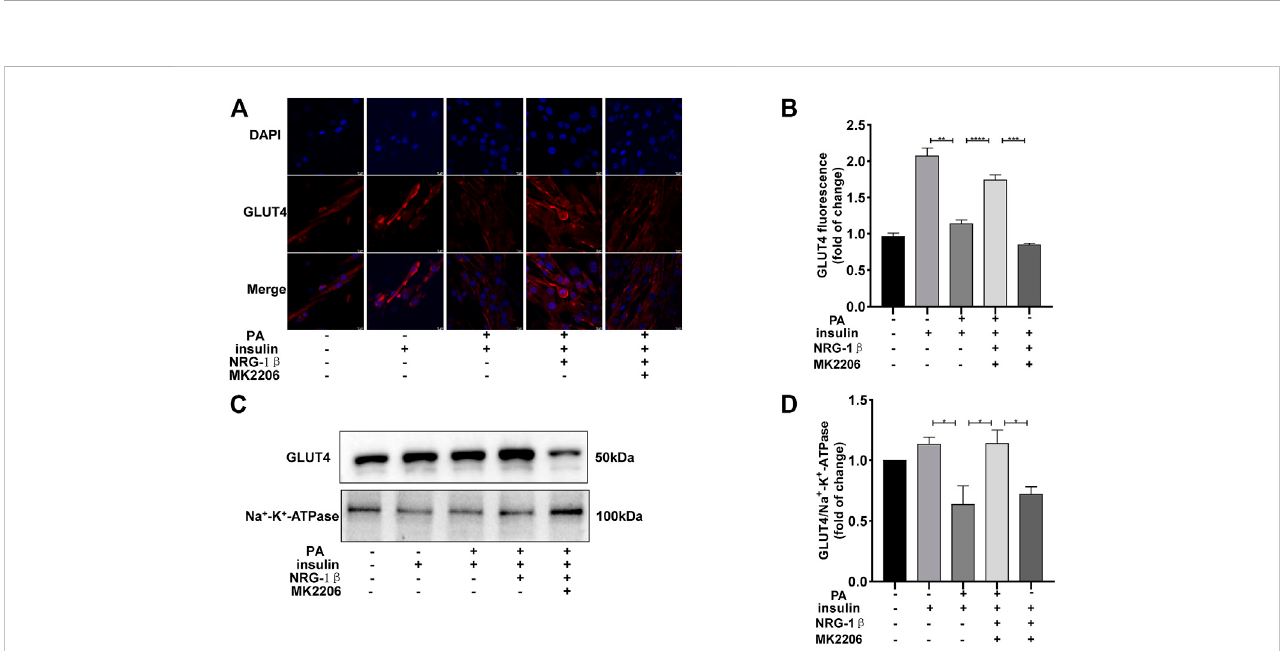
FIGURE 4 NRG-1 β promoted the translocation of GLUT4 in PA-treated C2C12 myotubes by activating the PI3K/AKT signaling pathway. Effects of MK2206 of GLUT4 translocation in PA-treated C2C12 myotubes, GLUT4 was detected by using a fl uorescent anti-GLUT4 antibody (Scale bar: 10 μ m) (A,B) and Western blotting (C,D) . The data are presented as the mean ± SEM. * p < .05; ** p < .01; *** p < .001; **** p <